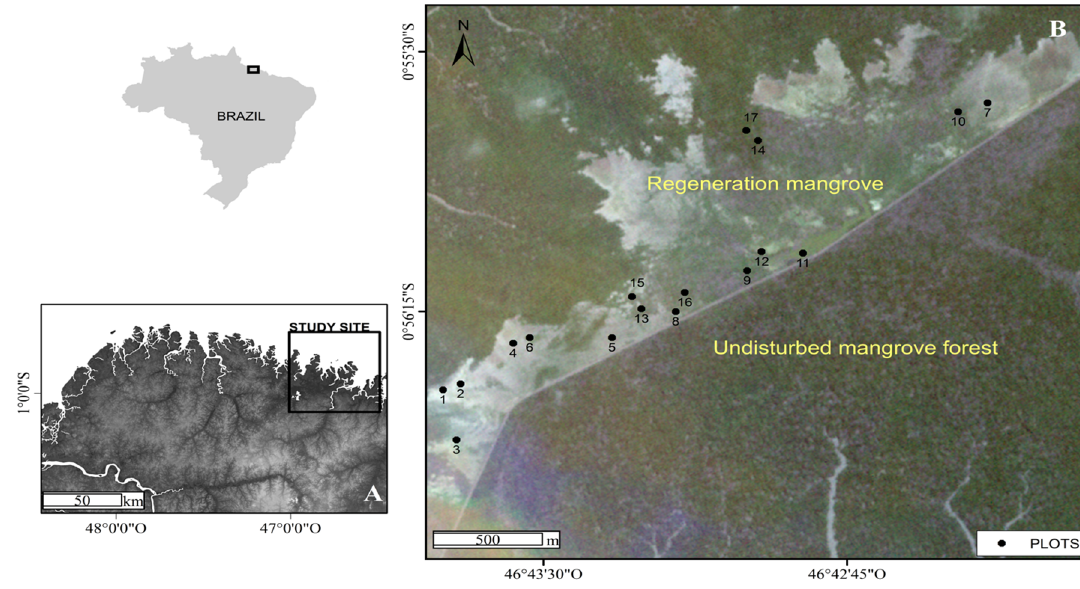
Figure 1. Map of the study area: ( A ) SRTM and ( B ) RapidEye image in 1R2G3B normal color composition. The figure also shows the location of the 17 plots analyzed in this study.